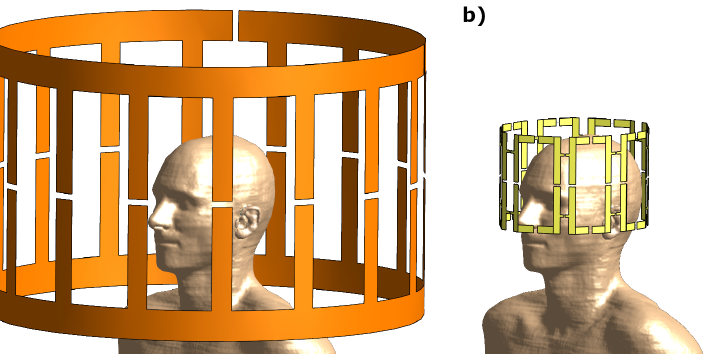
Figure 4. RF coils models. ( a ) 1.5T low-pass 16-leg birdcage body-coil. ( b ) 7T eight-channel head-coil.